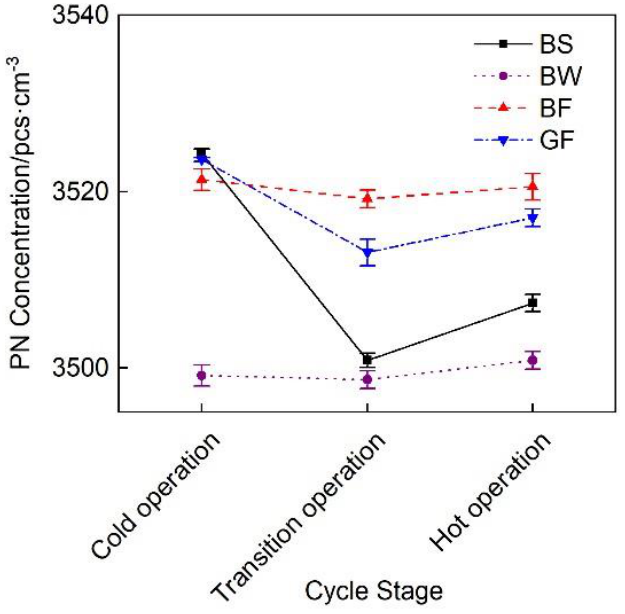
Figure 10. PN concentration change considering the different exhaust pipe covering schemes. Figure 11 shows the total emissions of gaseous pollutants and particulates during the WHTC cycle of the exhaust pipes with different covering schemes. It is observed that little difference existed in particulate matter emissions. Due to its better thermal insulation performance, the BF pipe achieved a high after-treatment system conversion efficiency, and the gaseous pollutant emissions were the lowest. The total emissions were 67.3%, 49.8% and 23.2% lower than those of the BS, BW and GF pipes, respectively.